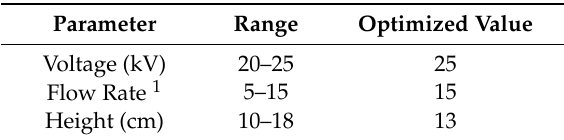
Table 1. Parameter optimization values. This table describes the optimized electrospray parameters determined using the Design-Expert ®